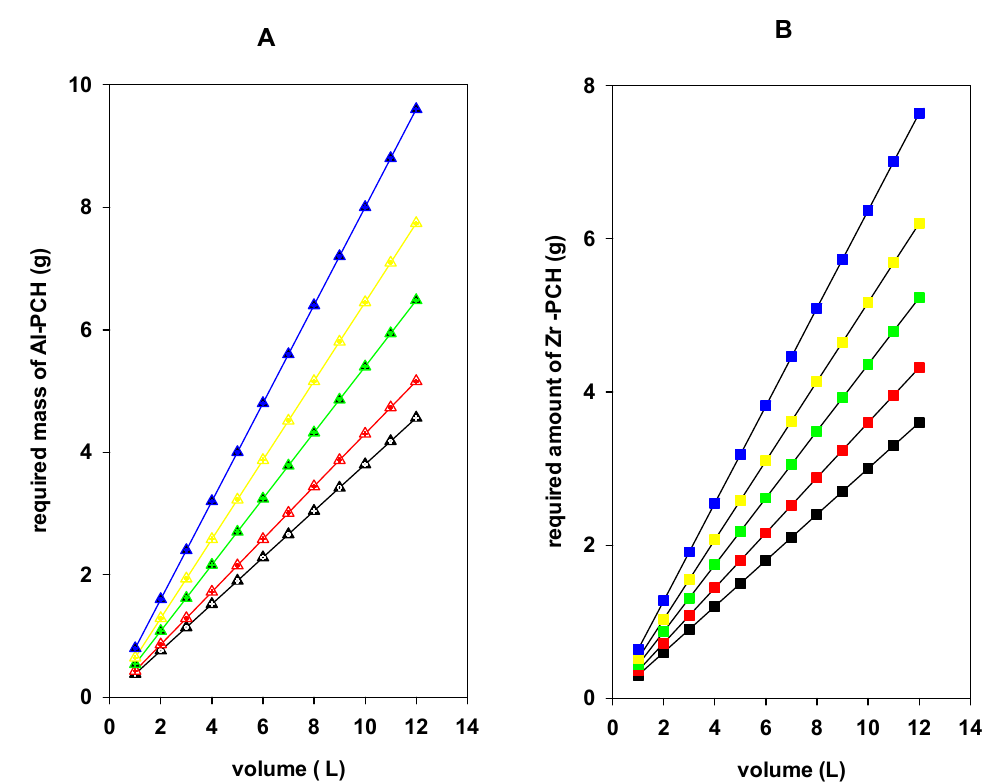
Figure 13. Required mass of ( A ) Al-PCH and ( B ) Zr-PCH to treat different volumes of BB-41 solu- tions.